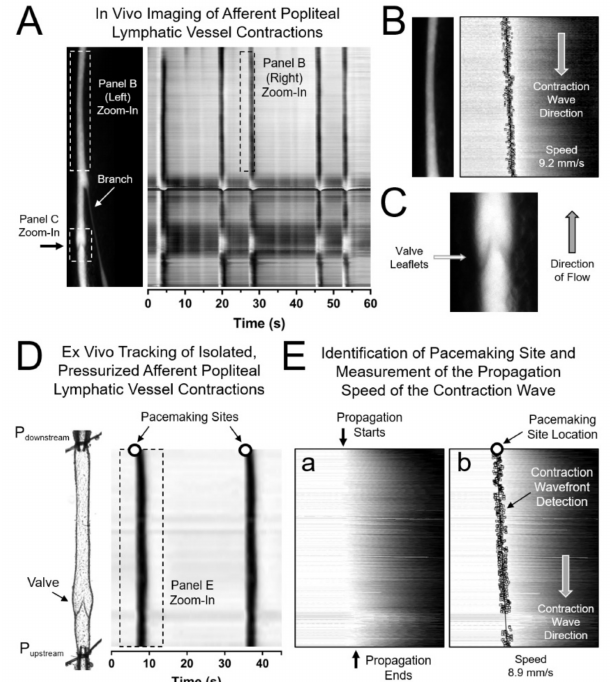
Figure 1. In vivo and ex vivo assessment of a ff erent popliteal lymphatic vessel contraction waves: ( A ) In vivo imaging of the lymphatic vasculature in the hindlimb of a mouse following an injection of FITC tracer into the upstream popliteal lymphatic network. Five contractions along the entire imaged lymphatic segment are represented in a two-dimensional map (Space Time Map—STM) as 5 dark vertical bands extending along the entire height of the image / map); ( B ) Analysis of the propagation of the contraction wavefront for each contraction using STMs allows assessment of the direction of propagation and measurement of propagation speed in vivo; ( C ) In vivo image of a lymphatic valve; ( D ) STMs of contractions from isolated, cannulated, pressurized a ff erent popliteal lymphatic vessels; ( E ) Similar to the analyses performed in vivo, automated analysis of the propagation of the contraction wavefront allowed us to determine where the contraction initiated (the pacemaking site) as well as the direction and speed of propagation. In panel E-a, notice the horizontal shift between where the contraction wavefront starts at the top of the image and where the contraction ends (bottom), which is right-shifted in the transformed image. Conduction / propagation speed is directly associated with the slope of the line that connects all the points along the propagation